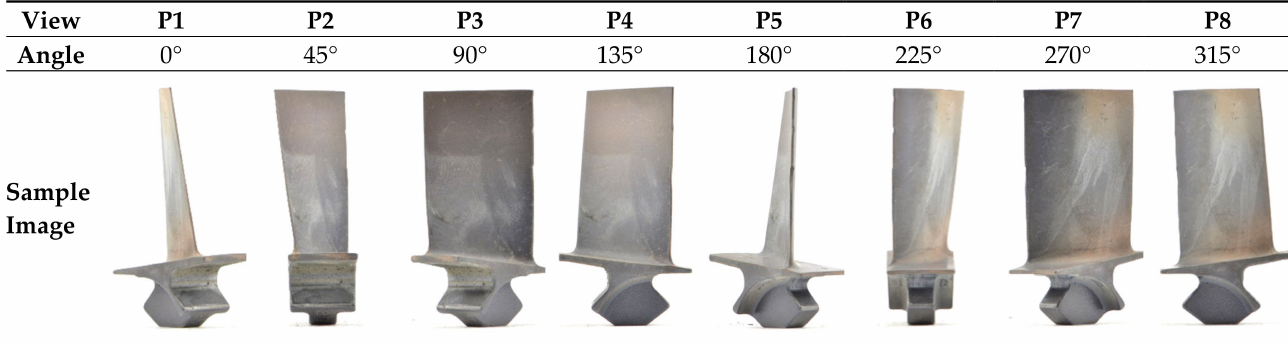
Figure 6. Different blade perspectives with 45 degree